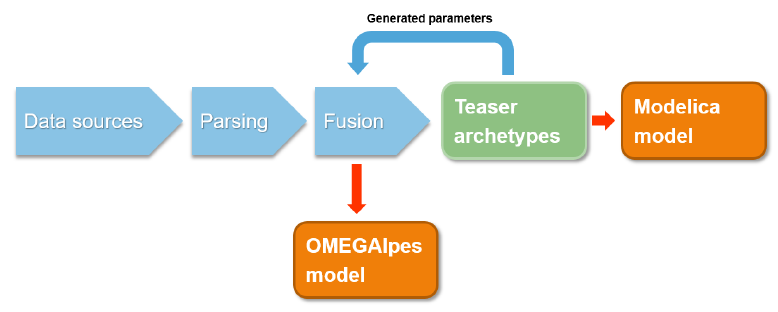
Figure 6. Workflow for district model